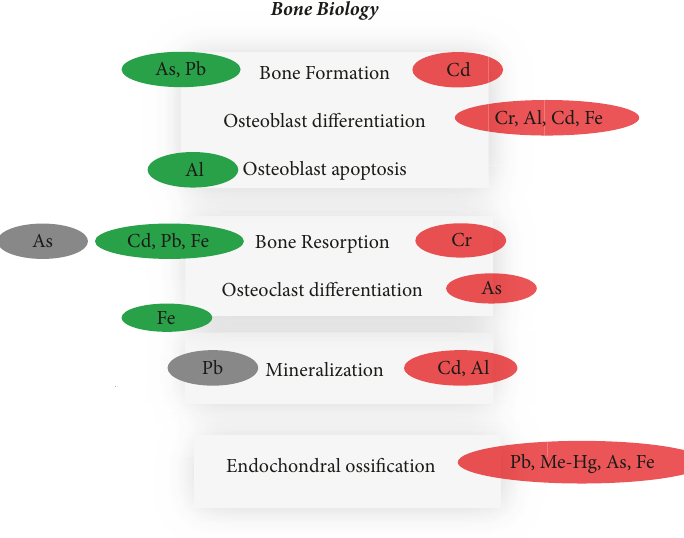
Figure 1: Schematicdiagram showing the main in vivo effects of metals on bone.Increase or stimulation (red), decrease or inhibition (green), alteration (increase or decrease)